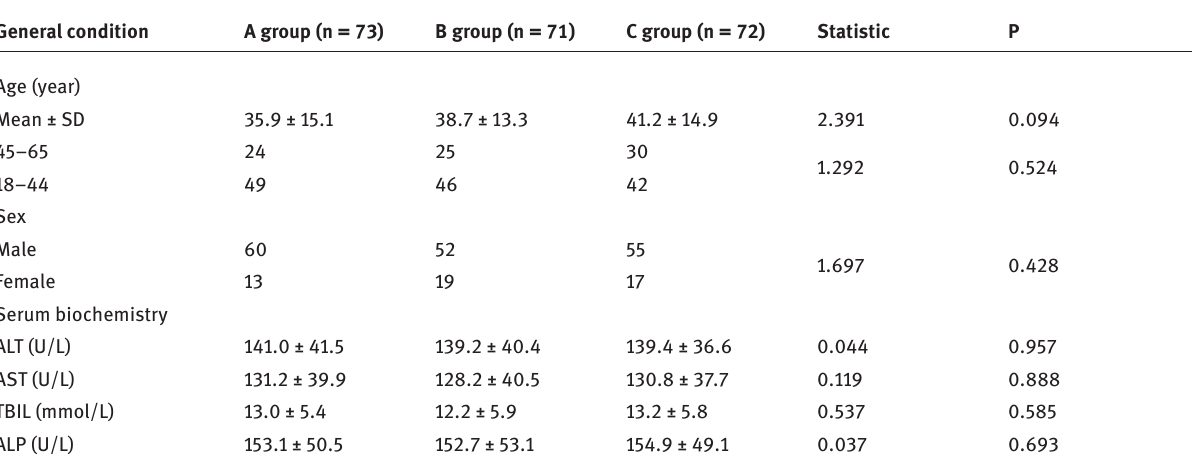
Table 1: Comparison of the general conditions of the three groups at baseline